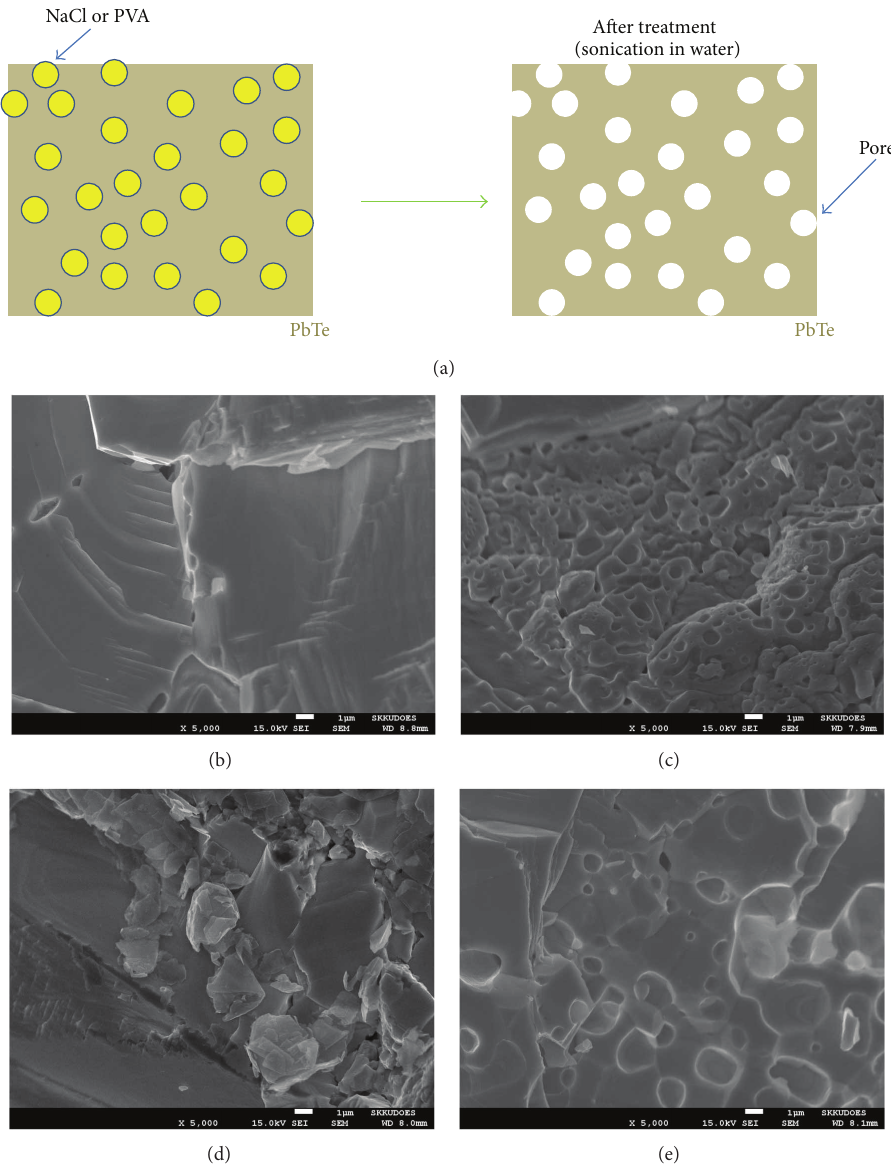
Figure2:(a)SchematicsofporegenerationinthePbTehostmatrixusingPVAorNaCl.Scanningelectronmicroscopyimagesofthefractured surfaces for (b) before and (c) after sonication for PbTe + PVA samples and (d) before and (e) after sonication for PbTe + NaCl, respectively.